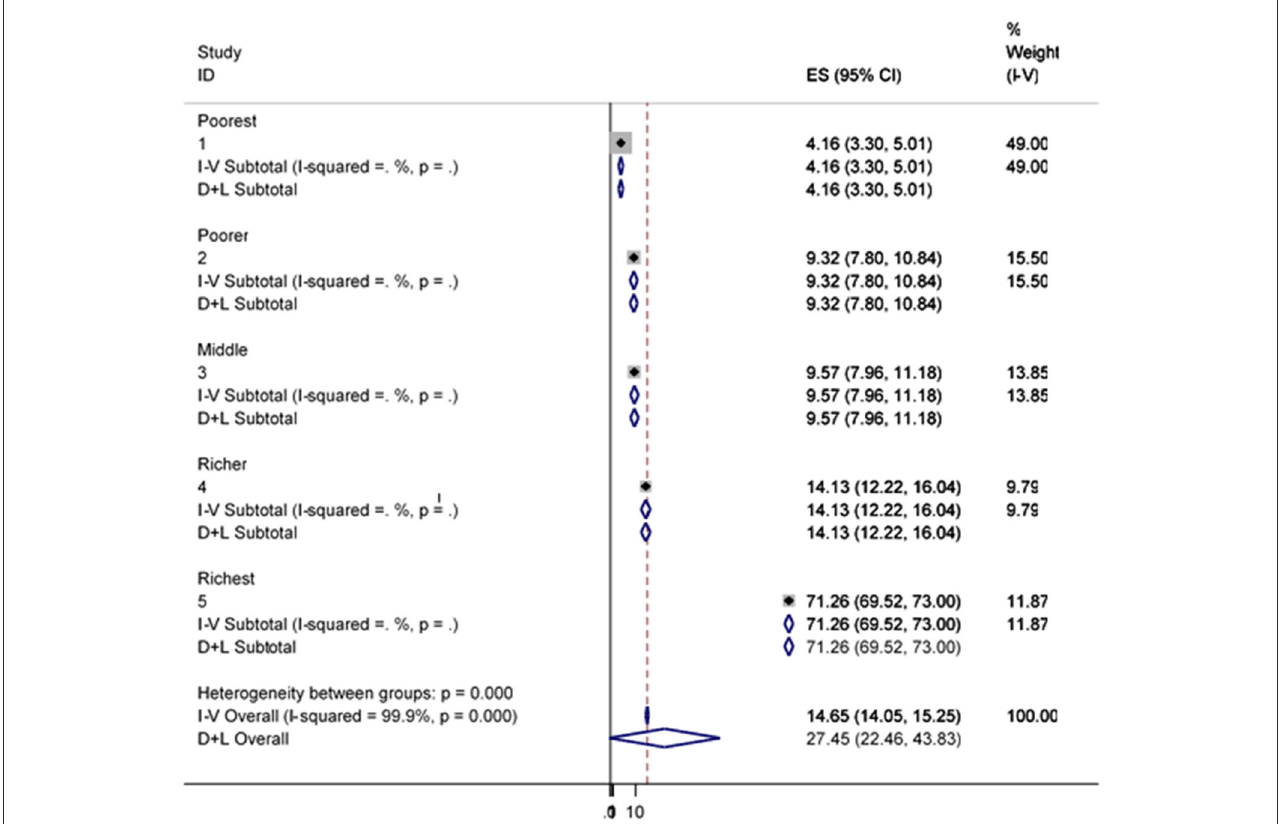
FIGURE6 Sub-group analysis of improved water source by educational status.